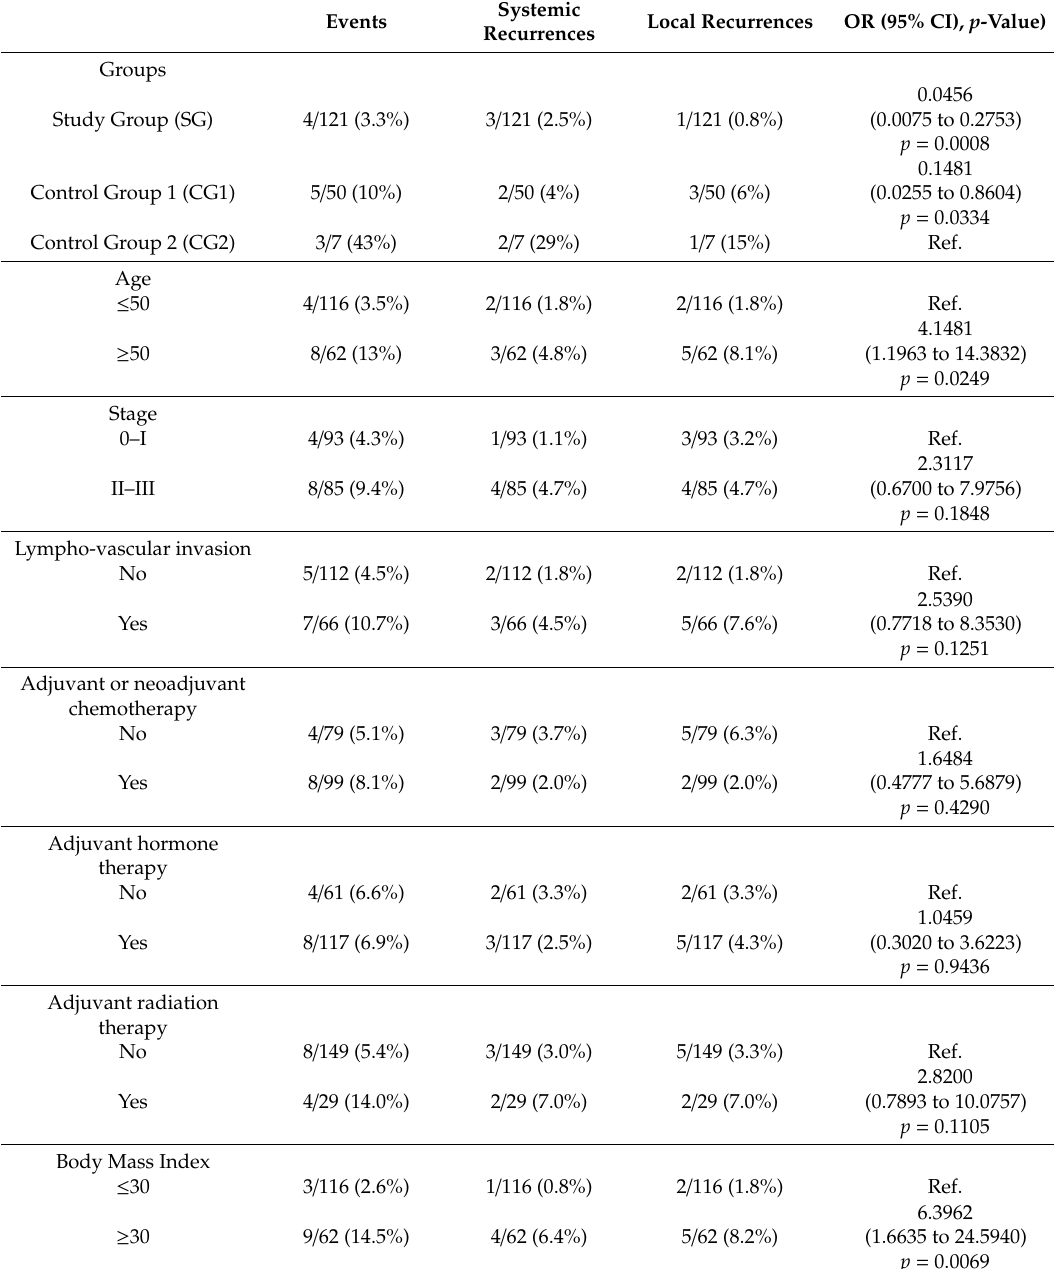
Table 1. Multivariate analysis of the risk of any recurrence (either local or systemic) related to several variables, including the three di ff erent surgical